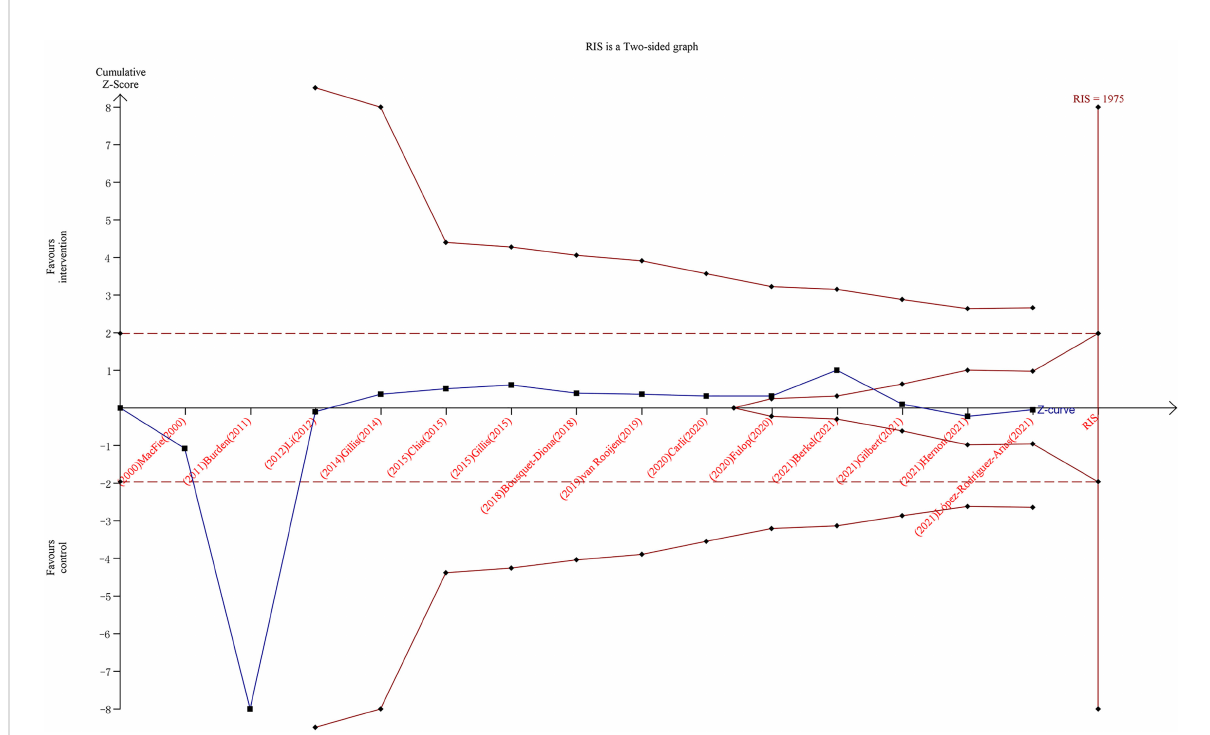
FIGURE 3 Trial sequential analysis for overall complications after colorectal surgery with or without preoperative prehabilitation strategies. The blue z- curve was drawn by applying a random-effects